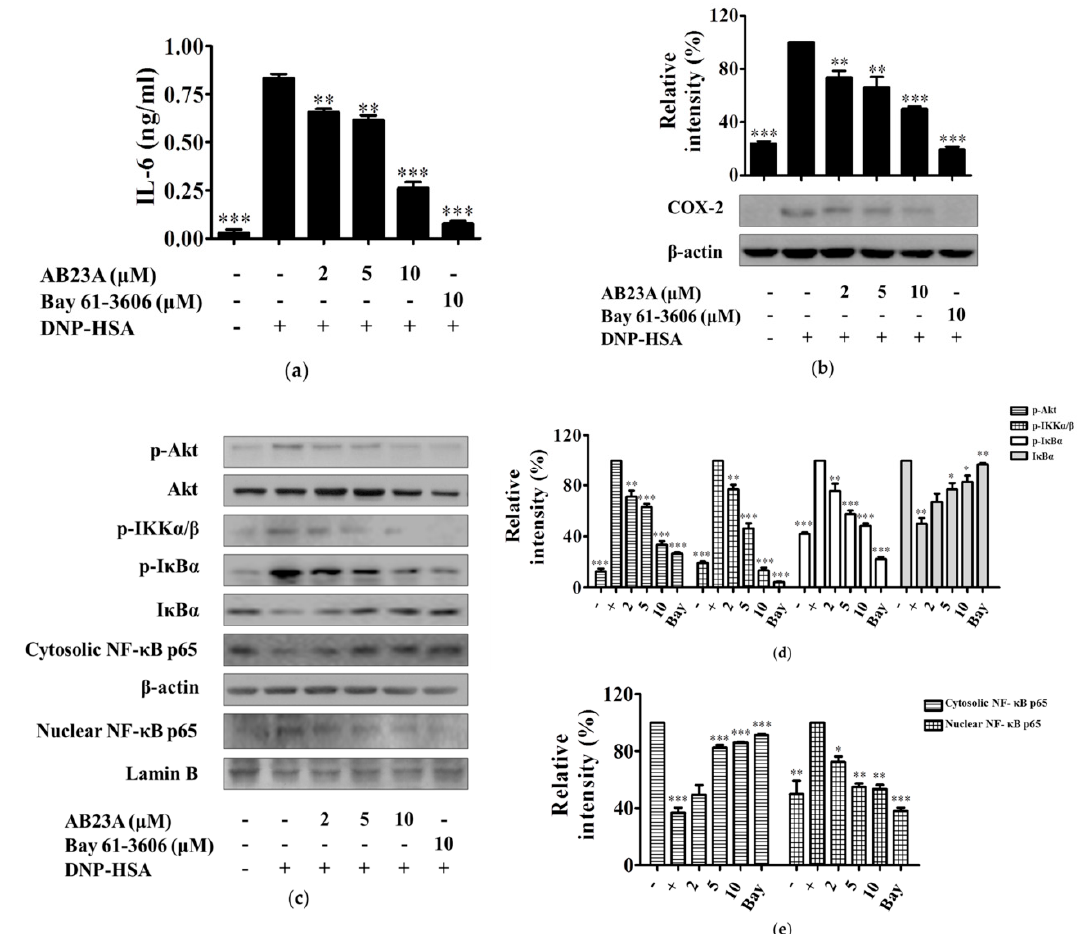
Figure 3. AB23A inhibits the production of IL-6 and the expression of COX-2 through part of the Akt/I κ B/NF- κ B pathway. ( a ) IgE-sensitized BMMCs were pre-treated with AB23A or Bay 61-3606 for 1 h and stimulated with DNP-HSA for 6 h. IL-6 were measured by ELISA. ( b ) IgE-sensitized BMMCs were pre-incubated with aspirin for 2 h to eliminate the activity of COX-1. After washing, the BMMCs were treated for 1 h with the AB23A or Bay 61-3606 and then stimulated with DNP-HSA for another 7 h. Cell lysates were immunoblotted with the antibody for COX-2. The relative ratio of COX-2 protein was measured by analyzing the immunoblot band intensity. ( c ) IgE-sensitized BMMCs were pre- incubated with AB23A or Bay 61-3606 for 1 h and then stimulated with DNP-HSA for 15 min. Cell lysates were immunoblotted for p-Akt/Akt, p-IKK α / β , p-I κ B α /I κ B α ; cytosolic and nuclear NF- κ B p65.